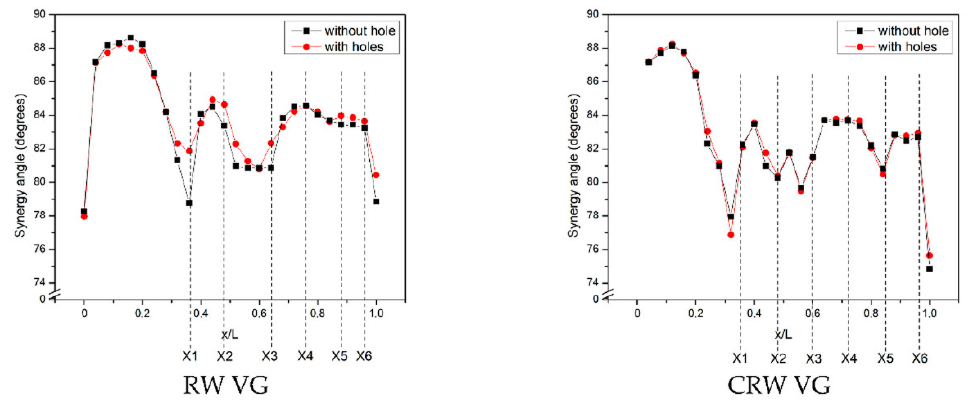
Figure 14. Synergy angle for RW and CRW VG use with and without holes.